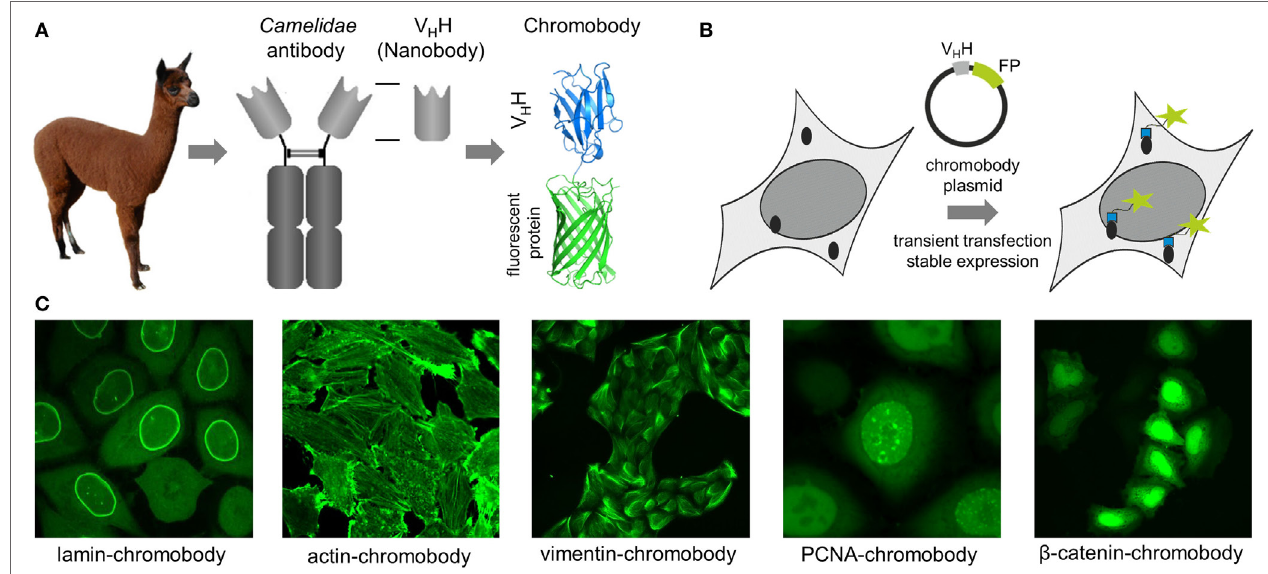
FiGURe 1 | (A) Schematic representation of a chromobody derived from a single-domain antibody of Camelidae . (B) Illustration of intracellular antigen binding of chromobodies followed by introduction and expression of DNA-encoded chromobody expression constructs. (C) Representative images of endogenous cellular structures visualized by recently developed chromobodies directed against lamin A, ACTB, vimentin, proliferating cellular antigen (PCNA), and β -catenin in living